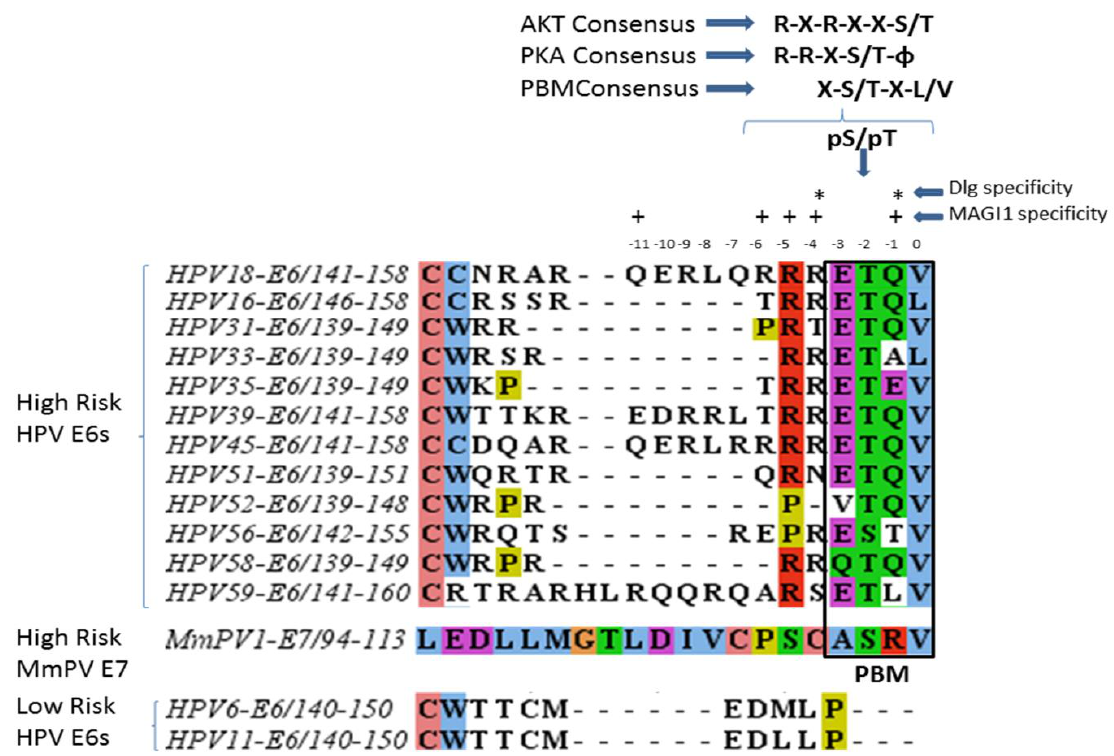
Figure 1. Figure 1. Papillomavirus oncoproteins show diversity in the PBMs and their kinase recognition sequences. The multiple sequence alignment of various HPV E6 proteins from different HPV types and the MmPV E7 using the Clustal X color scheme for the ClustalW